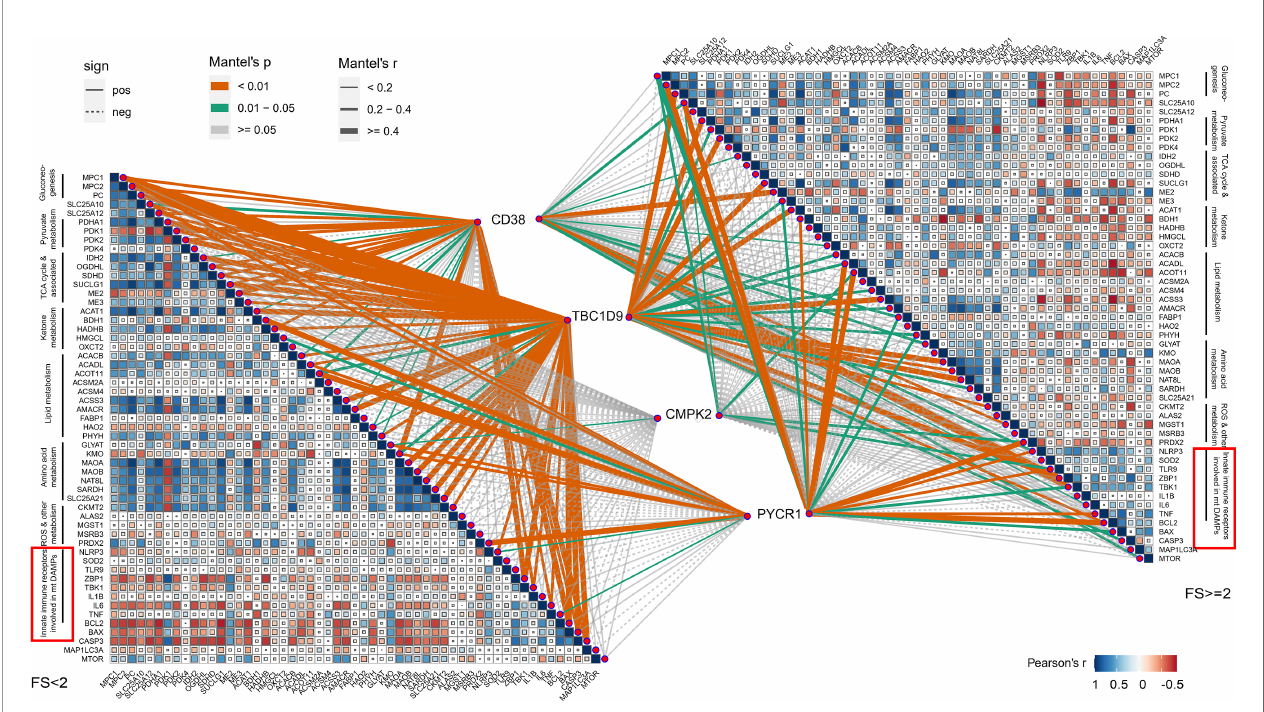
FIGURE 7 | Correlations between 4 hub genes and mitochondrial metabolism, damage-associated molecular patterns (DAMPs). Color represents Pearson ’ s correlation coef fi cient r of each hub genes (CD38, CMPK2, TBC1D9, and PYCR1) versus mitochondrial metabolism-related genes and DAMP gene expression, with blue color indicating a positive correlation (Pearson ’ s r < 0), red color indicating a negative correlation (Pearson ’ s r > 0). Statistical analysis was done with the Mantel test, with yellow line indicating p value <0.01, green line indicating 0.01 < p <